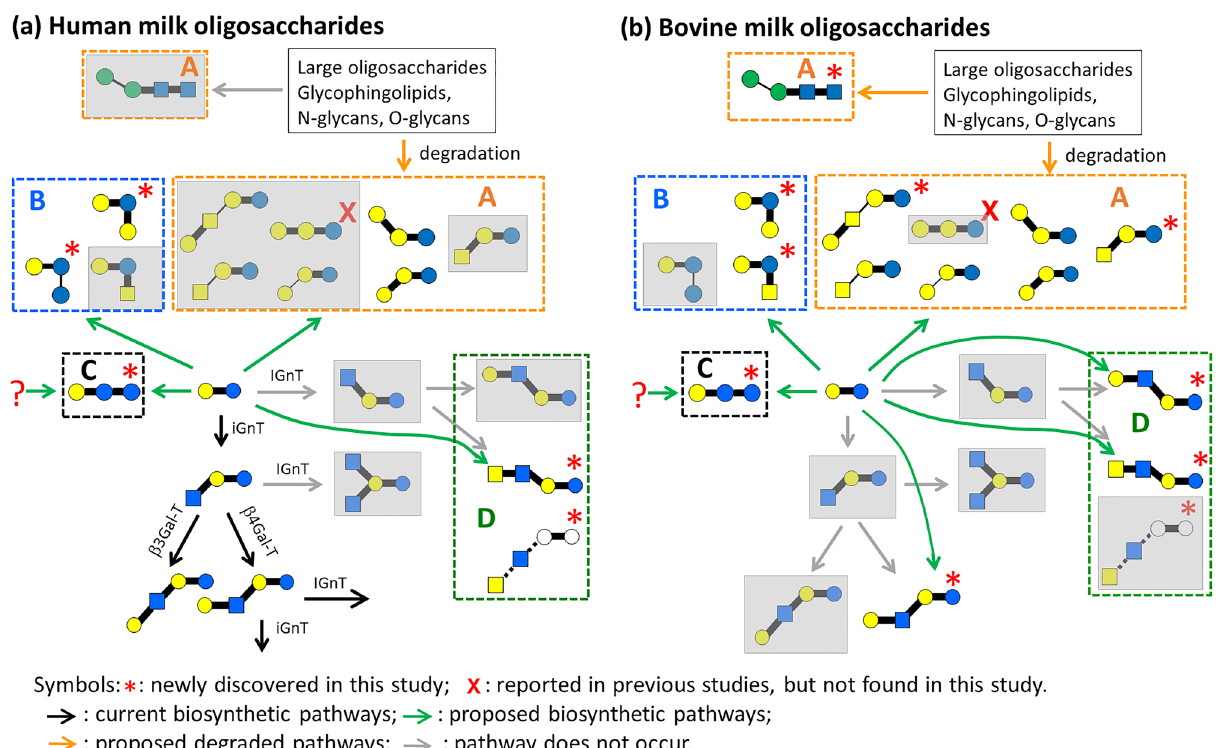
Figure 7. Biosynthetic pathways of neutral trisaccharides and tetrasaccharides consisting glucose, galactose, mannose, N-acetylglucosamine, and N-acetylgalactosamine. ( a ) Human milk oligosaccharides and ( b ) bovine milk oligosaccharides. To easily compare human and bovine milk oligosaccharides, all oligosaccharides discussed in this study are illustrated, and they are shown at the same positions in both biosynthetic pathways. Oligosaccharides in gray shadow were not found in this study. The discovered oligosaccharides are classified into four groups. Oligosaccharides in group A are generated by the elongation of lactose or the degradation from large oligosaccharides. Oligosaccharides in group B have lactrose at reducing end, but they have unusual linkages which are not found in other oligosaccharides. Oligosaccharide in group C does not have lactose at the reducing end. Oligosaccahrides in group D are tetrasaccharides, some of the trisaccahrides which lead to these tetrasaccharides from lactose were not can be classified into four groups. Oligosaccharides in group A (circulated by orange dash line), which have been found in previous studies, have lactose at the reducing end. The oligosaccharides in group A can be presented as moieties in other large glycans (e.g., N-glycans, O-glycans, and glycosphingolipids). They can be produced either by the elongation of lactose by undiscovered enzymes or the degradation from large glycans by other undiscovered enzymes. Oligosaccharides in group B (circulated by blue dash line) were identified in this study. Analogous to oligosaccharides in group A, oligosaccharides in group B have lactose at the reducing end. However, the linkages of the extension from lactose is unusual: oligosaccharides in group B have a branch with the linkage of β-Gal-(1 → 2)-Glc or α-Glc-(1 → 2)-Glc. These types of linkages are not found in any large oligosaccharides in milk, N-glycans, O-glycans, or glycosphingolipids, indicating they are not the degradation products of large oligosaccharides. A trisaccharide, β-Gal-(1 → 4)-Glc-β-Glc-(1 → 4)-Glc, found in this study is particular unusual and was classified into group C (circulated by black dash line). This trisaccharide does not have lactose at the reducing end, and it is not the moiety of any large oligosaccharides. This trisaccharide could be an extension of glucose to lactose at the reducing end or it might not be related to the extension of lactose (e.g., it starts from the extension at the nonreducing end of cellobiose instead of lactose). Group D consists of two tetrasaccharides. The tetrasaccharide GalNAc-(1 → 3)-GlcNAc-(1 → 3)-Hex-β-(1 → 4)-Hex could be the elongation of the trisaccharide β-GlcNAc-(1 → 3)-Gal-β-(1 → 4)-Glc by an enzyme that does not belong to the aforementioned four enzymes. The other tetrasaccharide is β-GalNAc-(1 → 4)-β-GlcNAc-(1 → 6)-Gal-β-(1 → 4)-Glc. However, the trisaccharide β-GlcNAc-(1 → 6)-Gal-β-(1 → 4)-Glc was not found. These findings suggest two possibilities. One possibility is